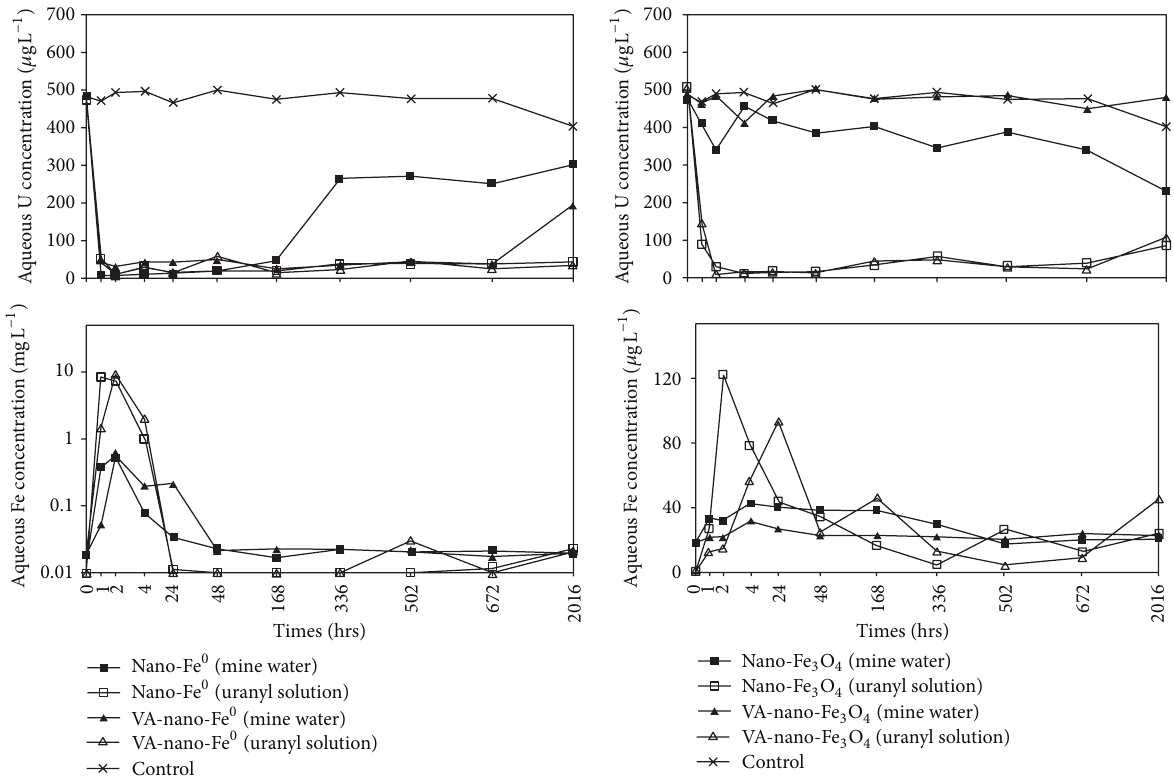
Figure 5: Aqueous uranium and iron concentrations as a function of reaction time (0–2016 hrs). The control is taken from the mine water system; a variation of < 10 𝜇 gL −1 was recorded in all other